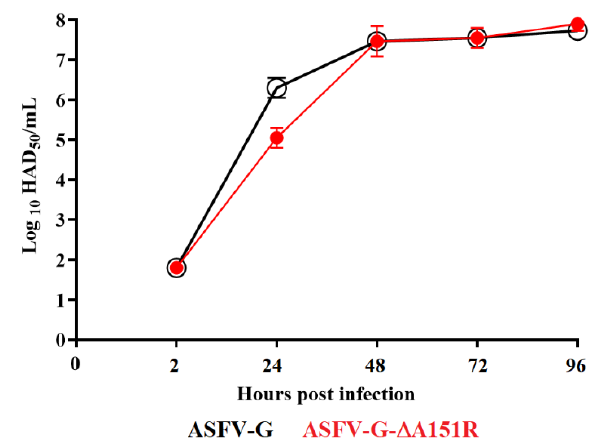
Figure 4. In vitro growth kinetics in primary swine macrophage cell cultures for ASFV-G- ∆ A151R and parental ASFV-G (MOI = 0.01). Samples were taken from three independent experiments at the indicated time points and titrated. Data represent means and standard deviations of three replicas. Sensitivity using this methodology for detecting virus was >log10 1.8 HAD 50 /mL. No significant differences in viral yields between viruses were observed at any time point tested, which was determined using the Holm–Sidak method ( α = 0.05) without assuming a consistent standard deviation. All calculations were conducted using the software Graphpad Prism version 8.